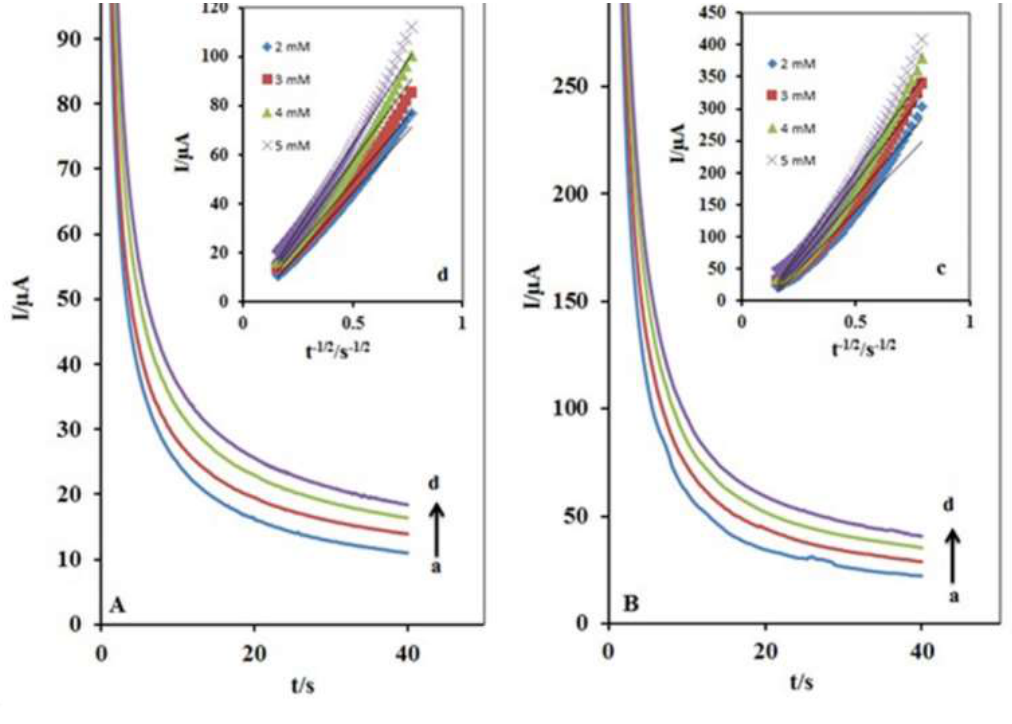
Fig. 8. (A) Chronoamperograms obtained in 0.1 M ammonia buffer solution (pH 7.0) in the presence of (a) 2, (b) 3, (c) 4 and (d) 5 mM of DA at PGA/TOHS/MWCNTs/CPE. (B) Chronoamperograms obtained in 0.1 M ammonia buffer solution (pH 7.0) in the presence of (a) 2, (b) 3, (c) 4 and (d) 5 mM of PRX at PGA/TOHS /MWCNTs/CPE. Insets: (d) Plots of I vs. t −1/2 obtained from chronoamperograms in (A) for DA and (d) Plots of I vs. t −1/2 obtained from chronoamperograms in (B) for PRX.